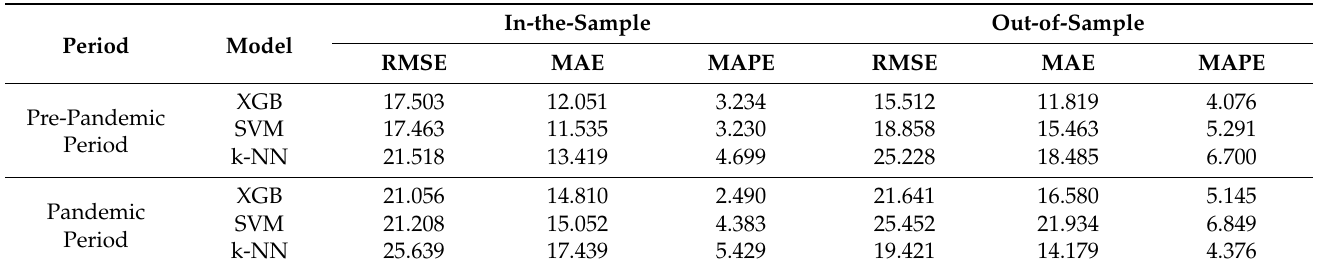
Table 4. The Out-of-Sample Period Performance of Machine Learning